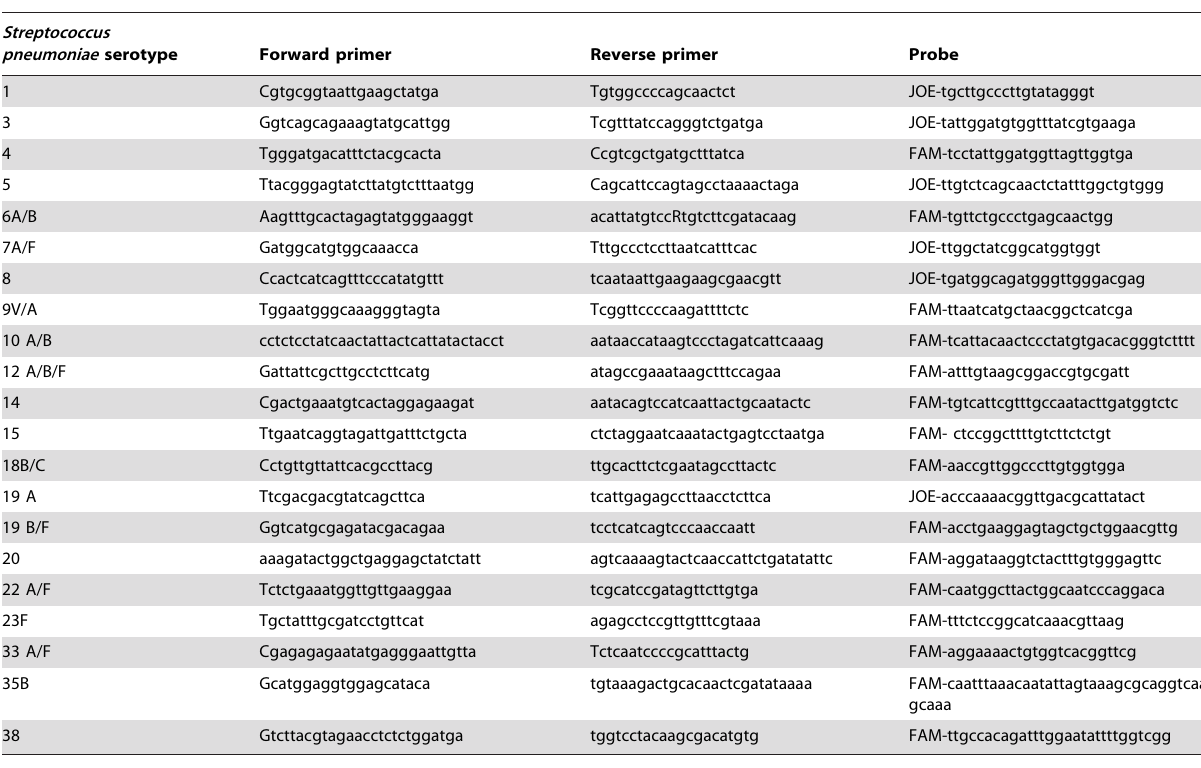
Table 1. Primer and probe sets for pneumococcal serotyping by Realtime